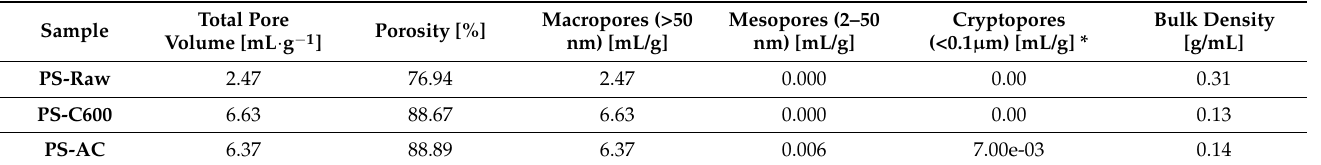
Table 5. Main results of mercury porosimetry for: total intrusion volume, porosity, division between macropores and mesopores according to IUPAC [30], and bulk density.